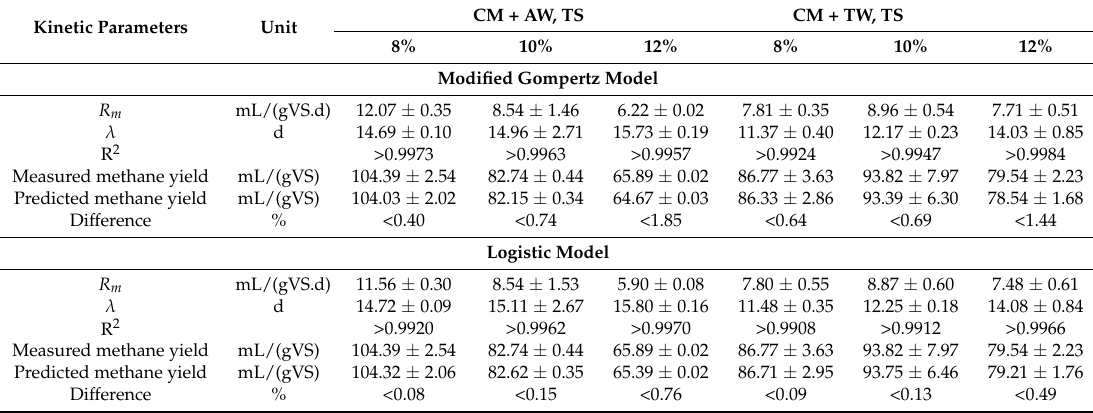
Table 1. Accumulated methane production, methane production rate ( R m ), and duration of the lag phase ( λ ) predicted by the modified Gompertz model and the logistic